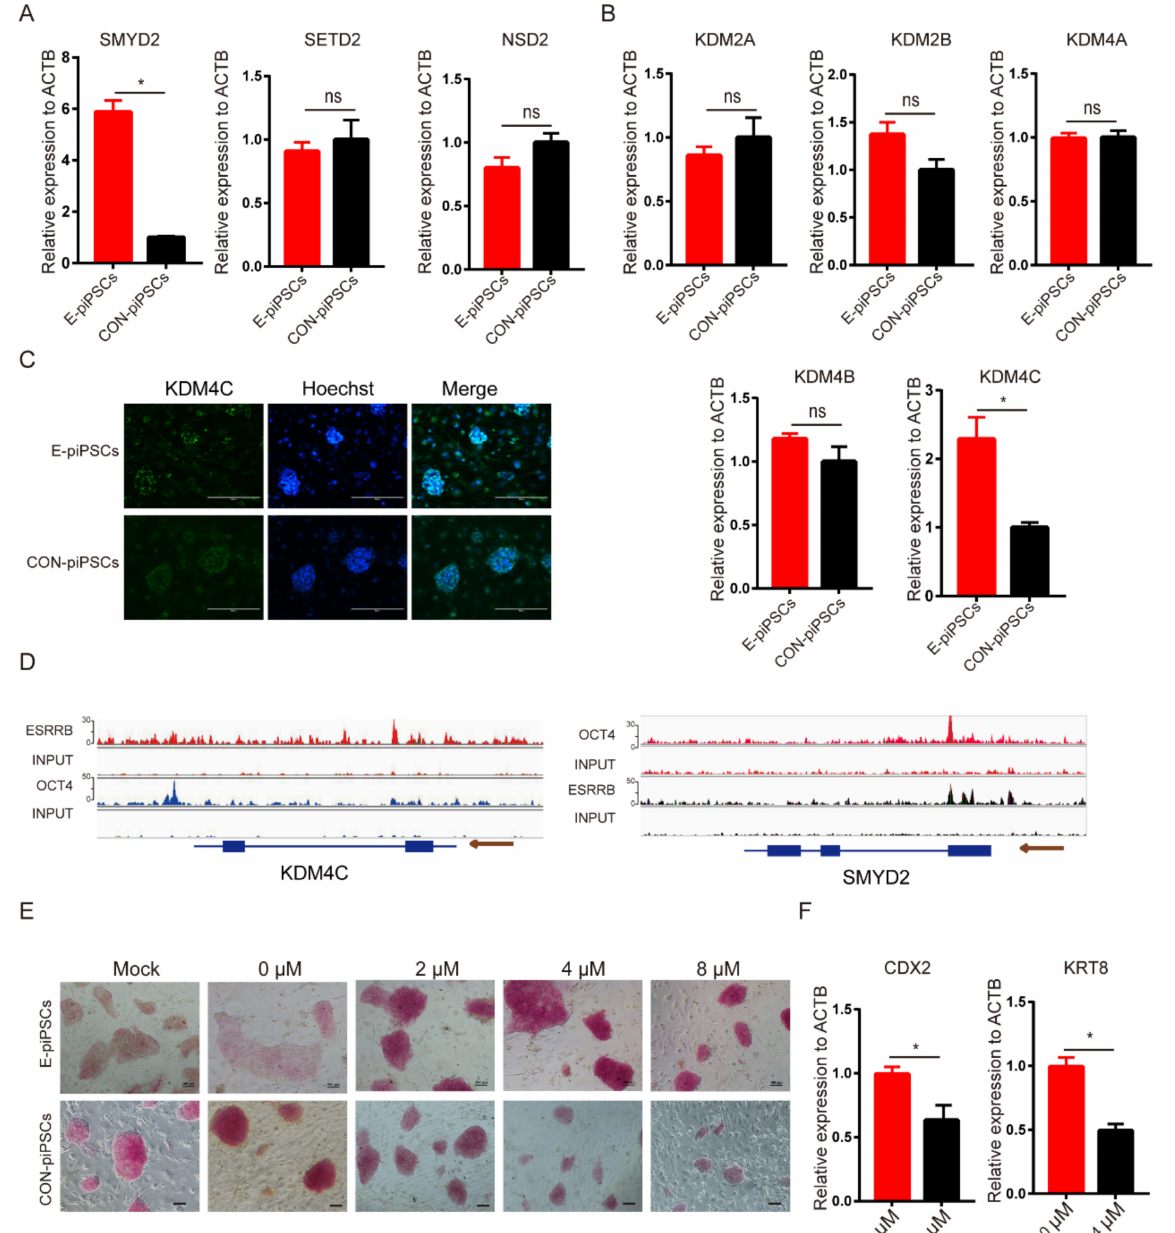
Figure 3. KDM4C is the core factor in the E-piPSCs. ( A ) qRT-PCR analysis of H3K36me methylases in CON- and E-piPSCs; * represents p < 0.05 and ns represents p > 0.05. ( B ) qRT-PCR analysis of H3K36me demethylases in CON- and E-piPSCs; * represents p < 0.05. ( C ) The immunofluorescence staining of KDM4C in CON- and E-piPSCs; the scale bar represents 200 µ m. ( D ) ChIP-seq analysis of ESRRB marks at KDM4C and SMYD2 using IGV. The size of the peak represents the degree of enrichment. ( E ) Representative image of AP-stained colonies after adding ML324 in CON- and E-piPSCs; the scale bar represents 100 µ m. ( F ) qRT-PCR analysis of CDX2 and KRT8 in E-piPSCs after adding 4 µ M ML324; * represents p <